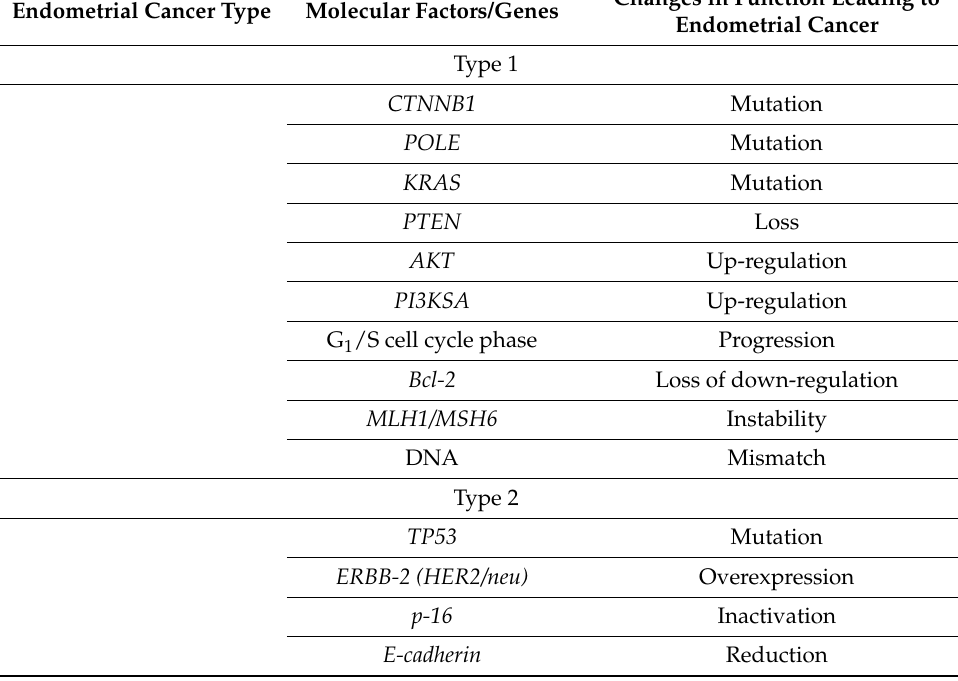
Table 2. Molecular mechanisms of endometrial cancer